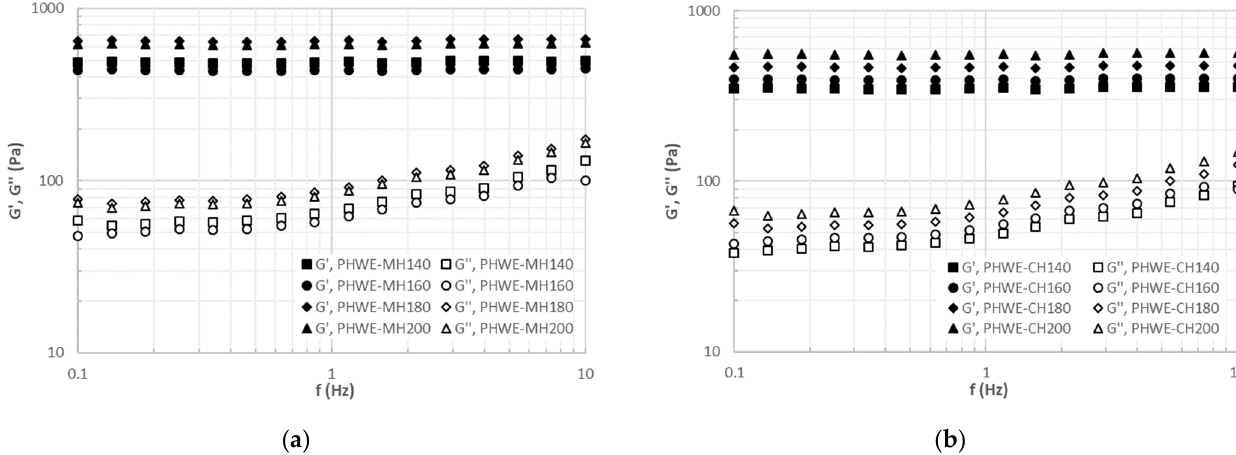
Figure 6. Viscoelastic profiles of gelling matrices prepared with liquid extracts from ( a ) PHWE-MH and ( b ) PHWE-CH and carrageenan (1%, 0.1 mol/L KCl) as a gelling agent.